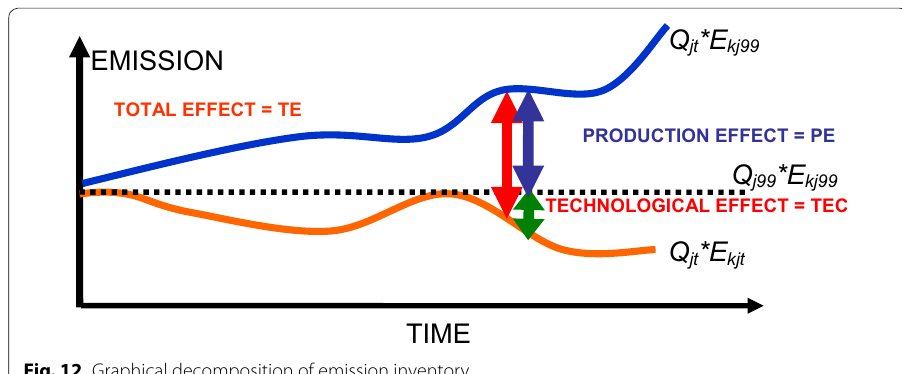
Fig. 12 Graphical decomposition of emission inventory